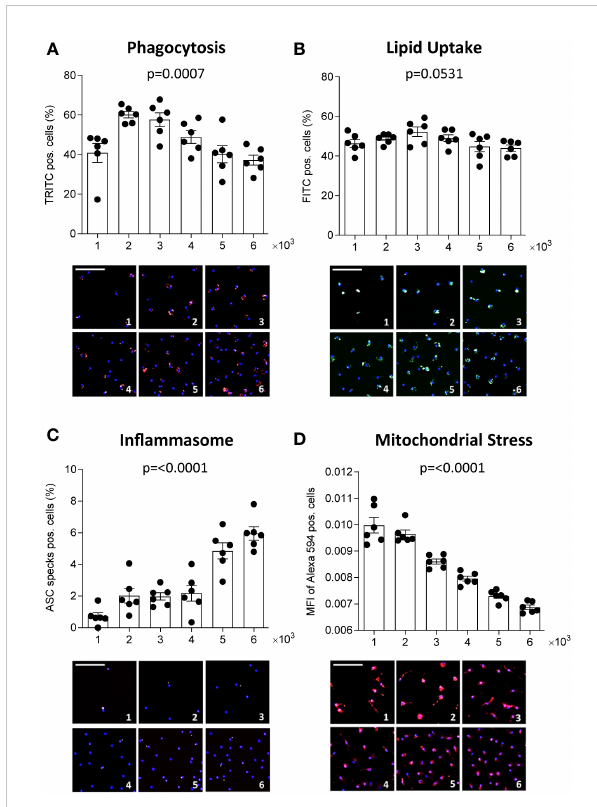
FIGURE 2 Density affects human primary M F function. CD14-positive monocytes were isolated from PBMCs of 6 healthy donors, pooled and seeded at the respective densities (1-6 x 10 3 cells/mm²) and differentiated to M F using 100 ng/ml macrophage colony- stimulating factor (M-CSF) for 7 days. Phagocytic activity (A , red ) , oxLDL uptake (B , green ) , in fl ammasome activation (C , red ) , and mitochondrial stress (D , red ) were assessed using the MacroScreen platform. Hoechst was used for nuclear labelling (blue). The scale bar in the representative fl uorescent images refers to 50 m M. The indicated p-values refer to overall signi fi cance, multiple comparison signi fi cance can be found in Supplementary Table 2. MFI: Mean fl uorescence